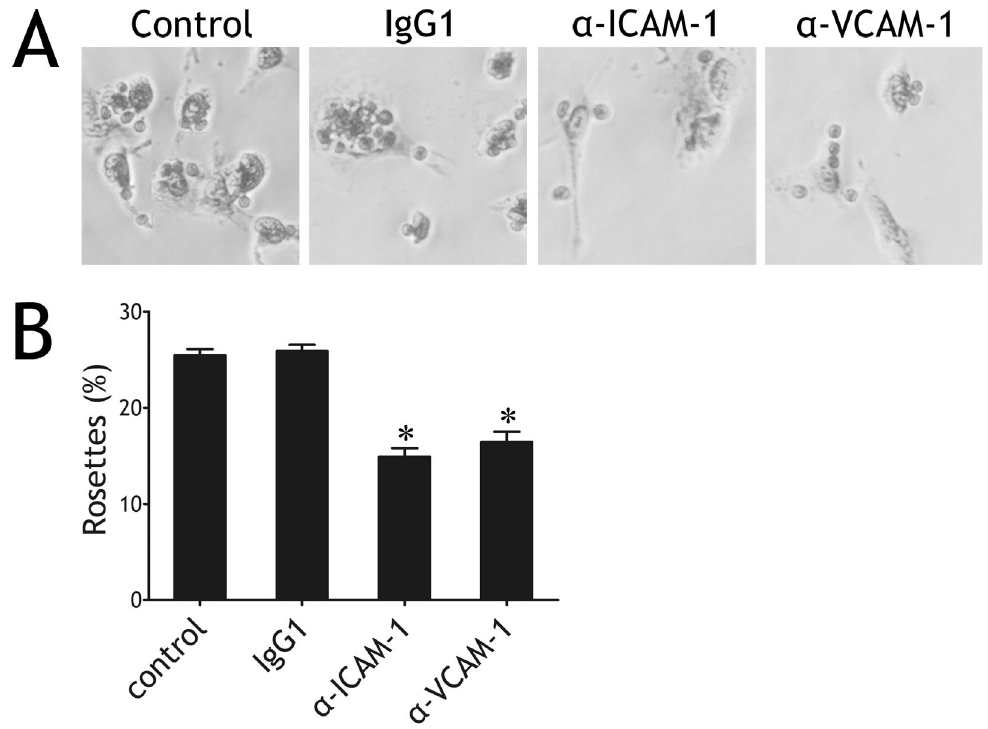
Figure 4. Intercellular adhesion molecule-1 (ICAM-1) and vascular cell adhesion molecule-1 (VCAM-1) expressed on pleural mesothelial cells (PMCs) were involved in the adhesion of CD4 + T cells. Pleural mesothelial cells isolated from tuberculous pleural effusion were cocultured with autologous CD4 + T. In some experiments, pleural mesothelial cells were preincubated with anti ‒ ICAM-1, ‒ VCAM-1 mAb, or an irrelevant isotype control (IgG1). 48 h later, nonadherent cells were gently removed by washing and the slides were stained with Wright staining. (A) Representative photomicrographs of CD4 + T cells adhering to pleural mesothelial cells. Original magnification: × 400. (B) Summary percentages of CD4 + T cell-pleural mesothelial cell rosettes. The results are reported as mean ± SEM from 5 independent experiments. The comparisons were determined by Kruskal- Wallis one-way analysis of variance on ranks. *p < 0.05 compared with control group or isotype